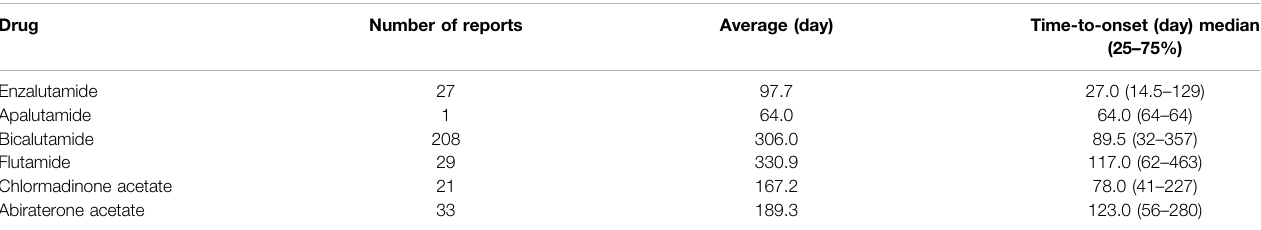
TABLE 4 | Medians for the time-to-onset of interstitial lung disease preferred terms (PTs) in the JADER database. Drug